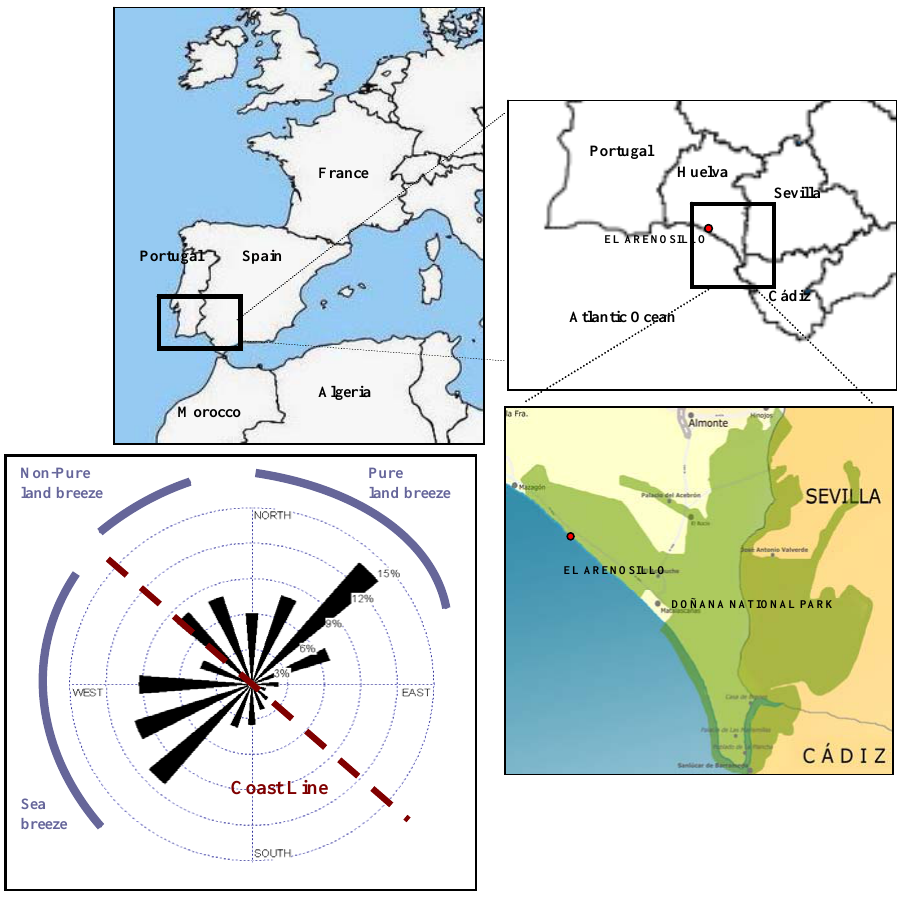
Fig. 1. Map of the Iberian Peninsula highlighting the location of El Arenosillo Station. The wind rose from 1 August 2004 to 31 July 2006 and the coastal line are also shown, indicating with an arc on the wind rose the wind directions for non-pure land, pure land and sea breeze